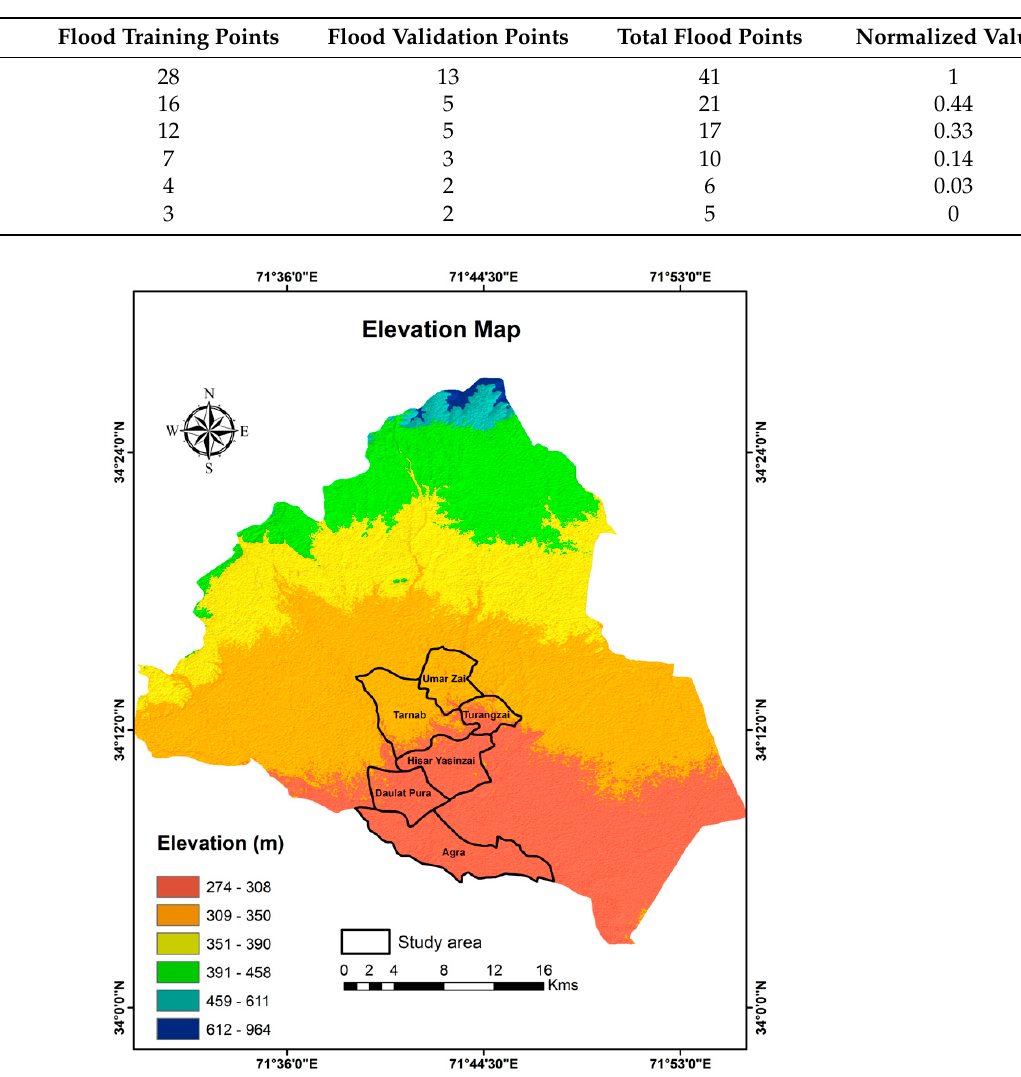
Table 2. Flood locations (flood training points and flood validation points).